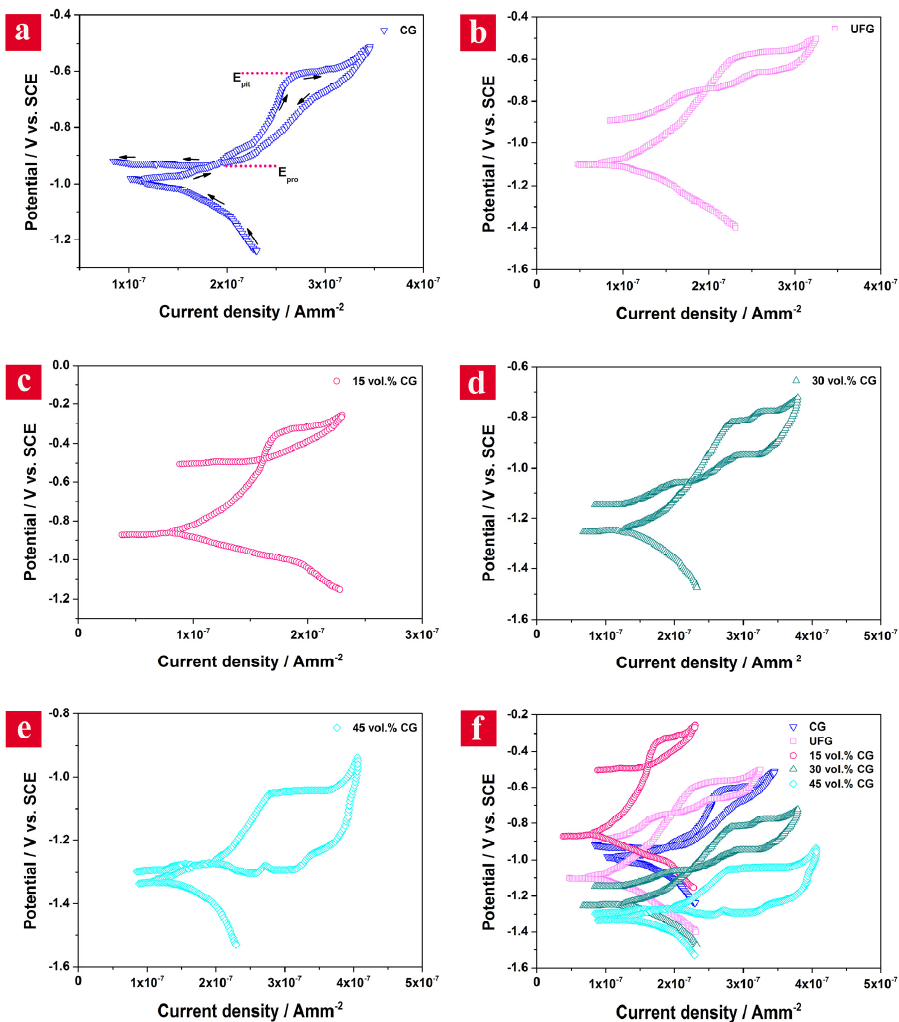
Figure 5. The steady ‐ state cyclic polarization curves of Al6063 alloys: ( a ) CG; ( b ) UFG; ( c ) 15 vol. % CG bimodal; ( d ) 30 vol. % CG bimodal; ( e ) 45 vol. % CG bimodal and ( f ) comparing the cyclic polarization curves for all of the samples.